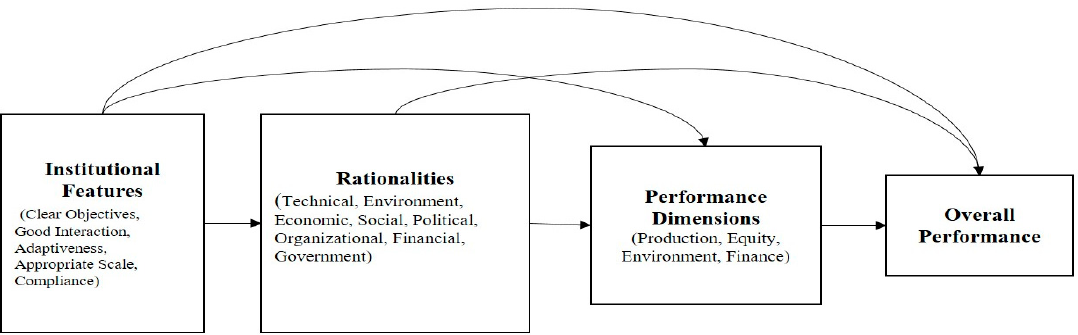
Figure 1. The conceptual framework.